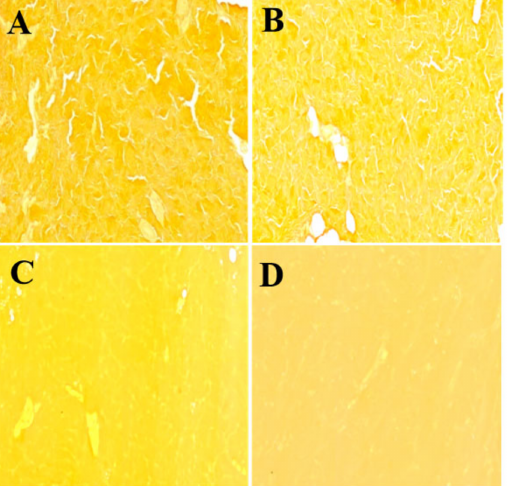
Figure 3. The effect of stewing time (0, 30, 60 and 120 min) on the ultra structure of collagen fibers. ( A – D ) represents samples at 0, 30, 60 and 120 min, respectively; magnification ×